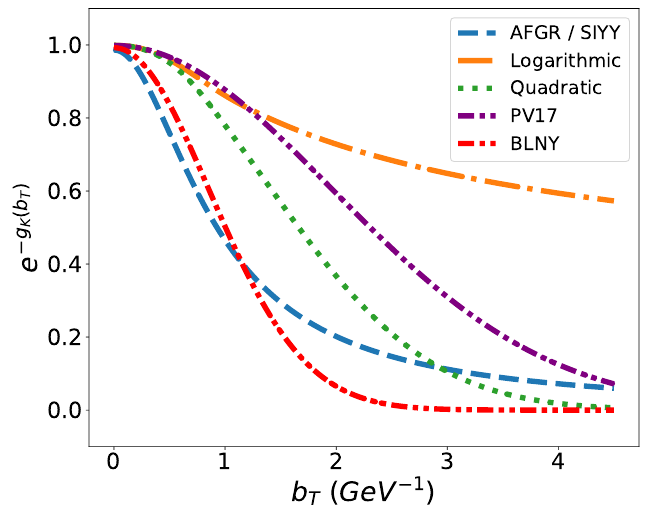
Figure 2 . Graphical representation of the different forms of the nonperturbative function exp( − g K ) , listed in eq. (3.33), with b = 0 . 6 GeV − 1 max